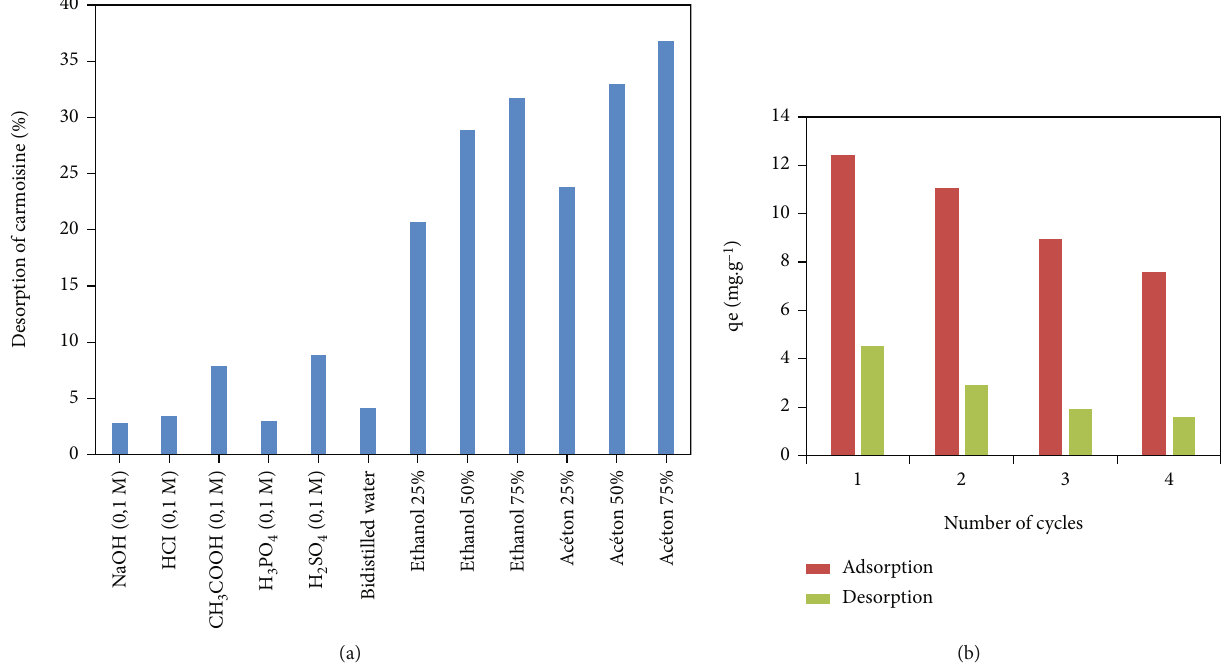
Figure 11: Desorption of carmoisine using (a) di ff erent eluents and (b) acetone (50%) after 4 The Δ H ° and Δ S ° values can be obtained from the slope and intercept of the Van ’ t Ho ff plots of lnKd versus 1/T Figure 9. The shape of the curve is considered satisfactory due to the correlation coe ffi cient obtained. The values of Δ G ° , Δ H ° , and Δ S ° are given in Table 2. Whatever the temperature tested, Δ G ° is negative, indicating the spontaneous nature of carmoisine adsorption on ND. The positive value of Δ H ° indicates the endothermic nature of the adsorption with a strong interaction of carmoisine with ND. In addition, the positive value of Δ S ° suggests that the randomness at the adsorbent/adsorbate interface increases during the adsorption of carmoisine by ND.